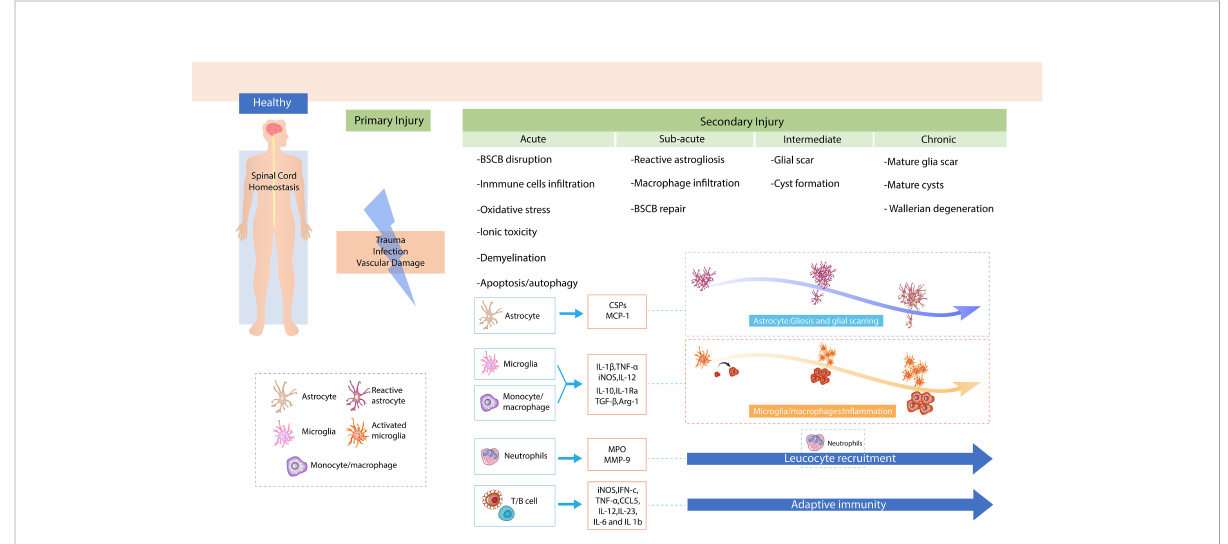
FIGURE 1 The mechanism of spinal cord injury (SCI). Demonstration of primary injury and secondary injury, including four phases of SCI after trauma to the spinal